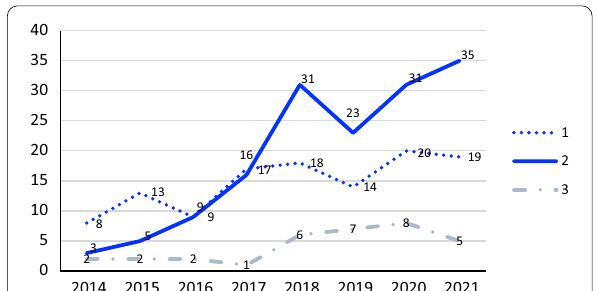
Fig. 3 Distribution of publications by school level focus and year (Note: 1 K-12 school level, 2 =